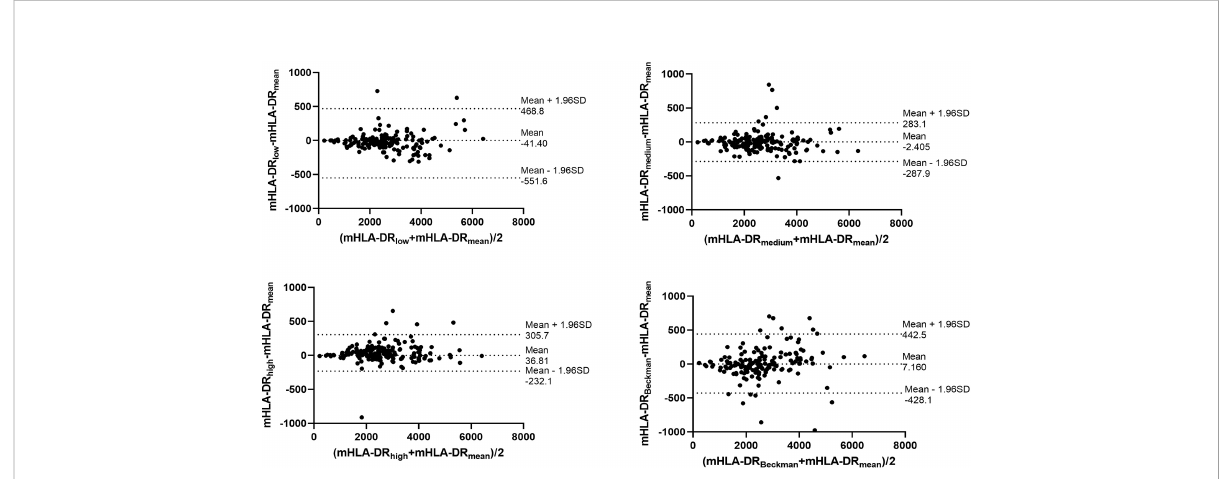
FIGURE 3 The Bland-Altman plot for the four MESFs of mHLA-DR under BD FACSCanto II with high/medium/high voltages and Beckman Coulter DxFlex with proper voltage. The agreement between the mean value of the four results and each result of mHLA-DR was assessed over the full range. The fi xed range was de fi ned as mean ± 1.96SD. mHLA-DR, monocyte HLA-DR; SD, standard deviation; MESF, molecules of equivalent soluble fl uorochrome.